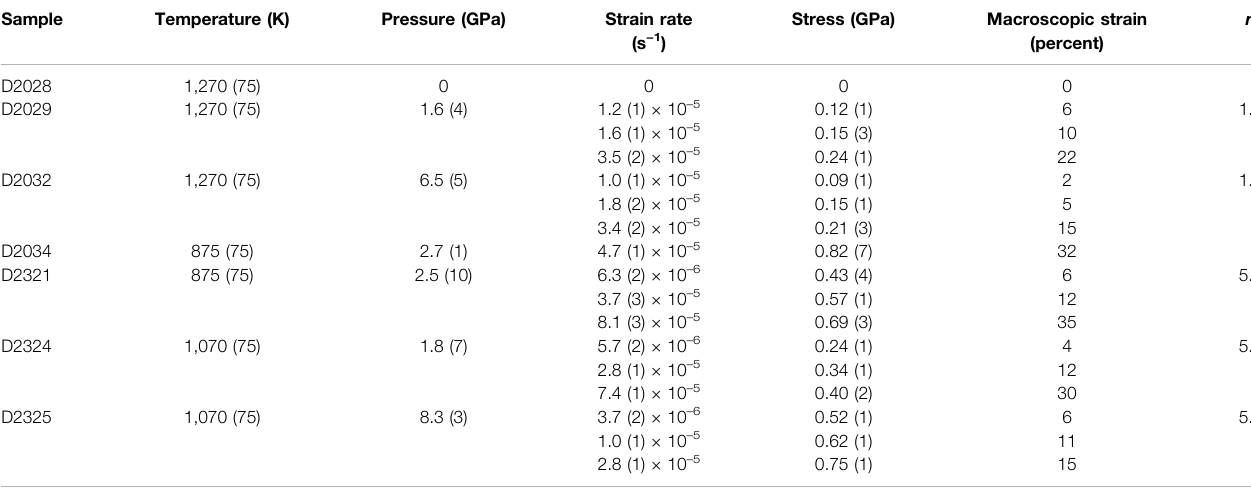
TABLE 1 | Experimental results: temperature, average hydrostatic pressure, strain rate, stress and fi nal macroscopic strain at each deformation step. Sample Temperature (K) Pressure (GPa) Strain rate